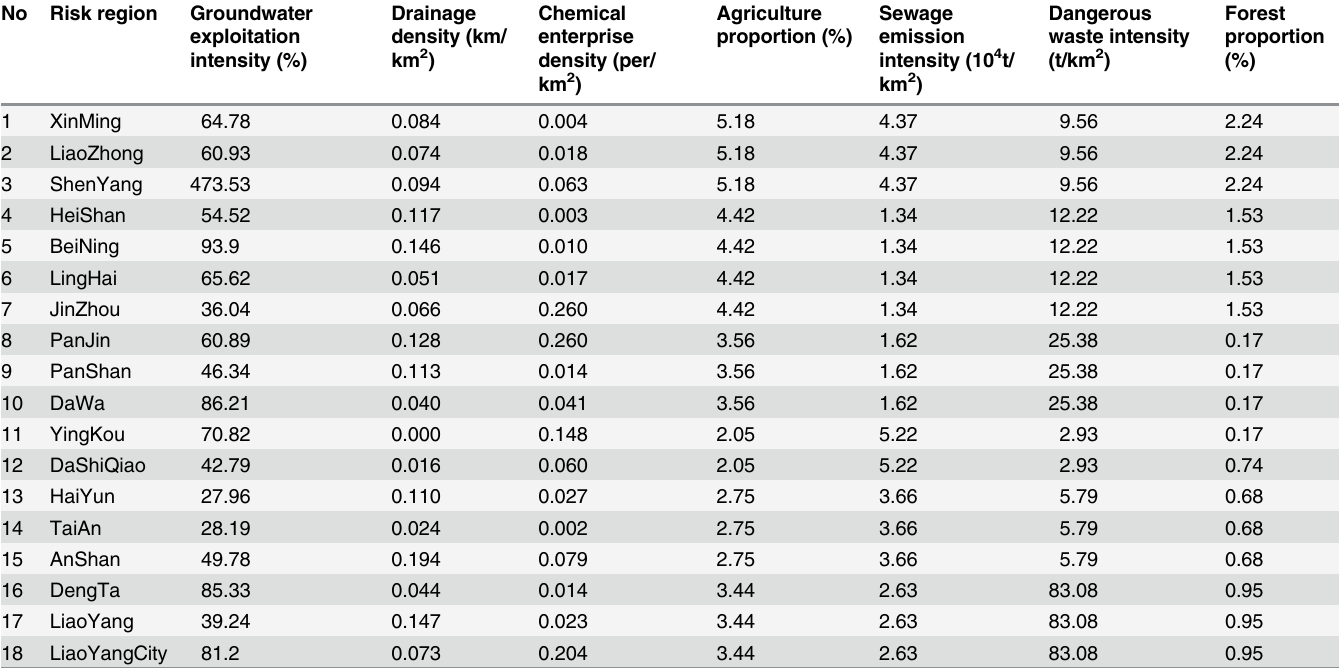
Table 3. Sources of risk in the Lower Liao